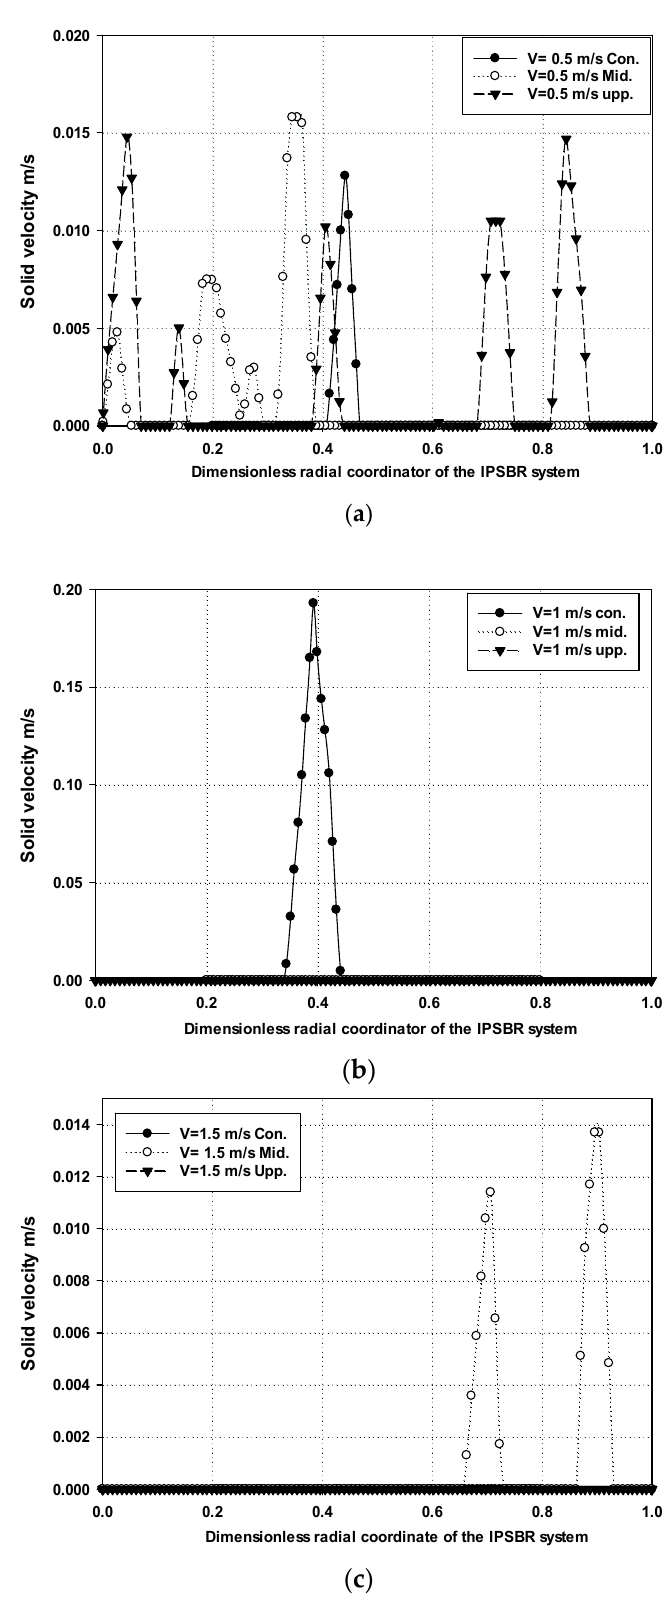
Figure 2. Effect of feed gas velocity (( a ) 0.5 m/s, ( b ) 1 m/s, and ( c ) 1.5 m/s) on the average solid velocity at a constant orifice diameter of 0.003 m, gas head of 0.25 m, mixing particle diameter of 0.0135 m, and total mass of mixing particle of 0.06 kg in the conical, middle, and upper regions. (b) Effect of Orifice Diameter on Average Solid Velocity Figure S1a,b depicts the effect of two different orifice diameters (0.003 and 0.005 m) on the average solid velocity in the three regions. The results were extracted for a constant feed gas velocity of 1 m/s, gas head of 0.25 m, mixing particle diameter of 0.0135 m, and mixing particle load of 0.06 kg. It was found that increasing the orifice diameter from 0.003 to 0.005 m reduced particle velocity throughout the upper region and made it easier to detect, as shown in Figure S1b. The mixing particles, on the other hand, were not detected when a smaller orifice diameter was used, as shown in Figure S1a. It is clear from Figure S1b that the particle velocity was not detected in the conical and middle regions. Whereas, in the upper region it reached a peak value of almost 0.1 m/s. This is also connected to the gas velocity inside the reactor, which increased inside the reactor at higher orifice diame- ters, owing to the creation of larger bubble sizes. Because of that, the particles would not be well distributed in a uniform profile throughout the reactor at higher orifice diameters [36]. (c) Effect of gas head on average solid velocity The effect of gas head on the average solid velocity distribution was studied at a con- stant feed gas velocity of 1 m/s, 0.003 m orifice diameter, mixing particle diameter of 0.0135 m, and total mass of mixing particle of 0.06 kg in all three regions. In the conical region, it was expected to see high dispersion and turbulence of the particle distribution because that is the injection zone for those particles. Furthermore, the cross-sectional area of the conical region was smaller than those of the middle and upper regions. Therefore, a clear behavior was not detected in conical region. It can be seen in Figure 3a,b that more gas head resulted in an increase in the particle velocity in the middle and upper regions. From the simulated data of a gas head value of 0.15 m, it was found that the mixing particles at R = 0.2 to 0.6 had an average velocity of around of 0.04 m/s. However, in the same section with a gas head value of 0.35 m, the average solid velocity approached a value of around 0.06 m/s. A lower gas head meant a higher liquid level. As the liquid level increased this exerted more pressure on the mixing particles; therefore, a lower particle velocity was observed.